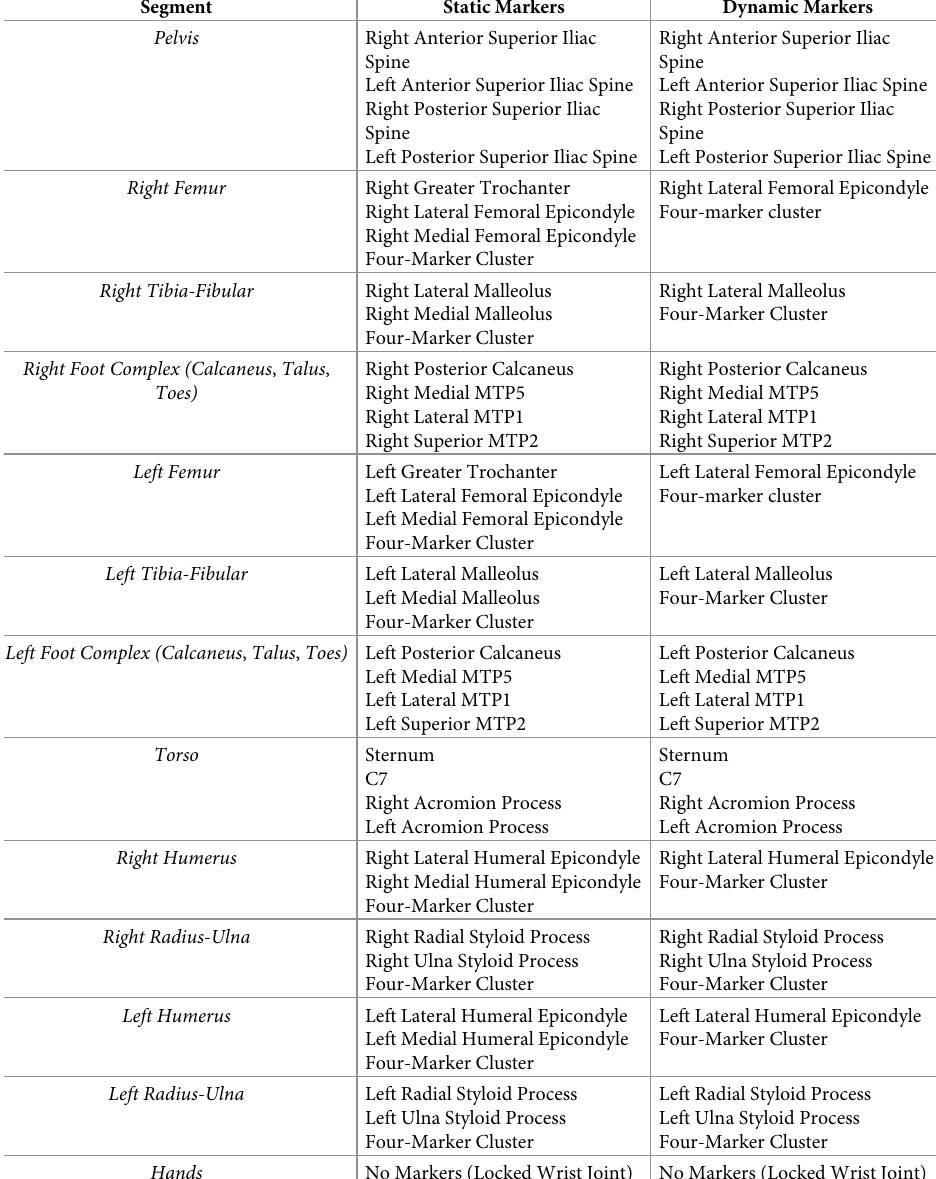
Table 2. Description of marker locations used for the 3D-Motion